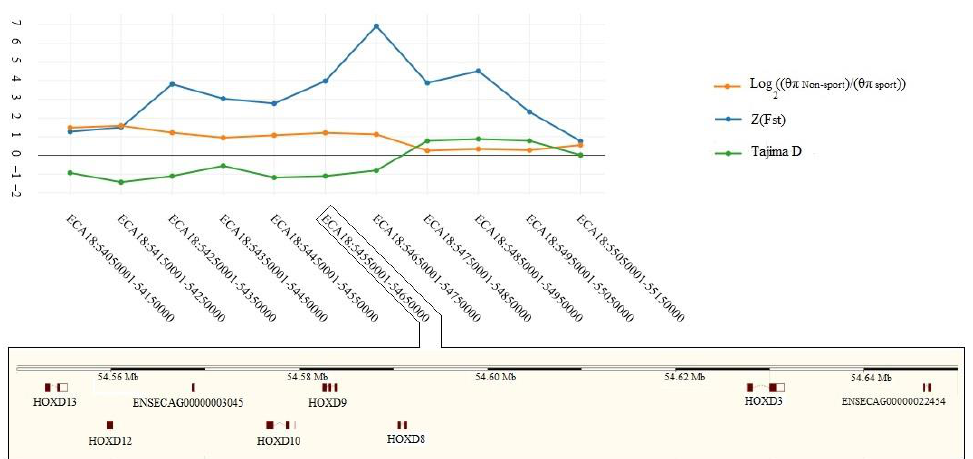
Figure 8. The log θπ (Non−sport) θπ ( Sport ) 2 ) ratios, Z(F st ) and Tajima’s D values distributions for each 100 kb window in ECA18: 54.05–55.15Mb. The ECA18: 54.55–54.65 Mb window includes HOXDs that are related to musculoskeletal system development processes.